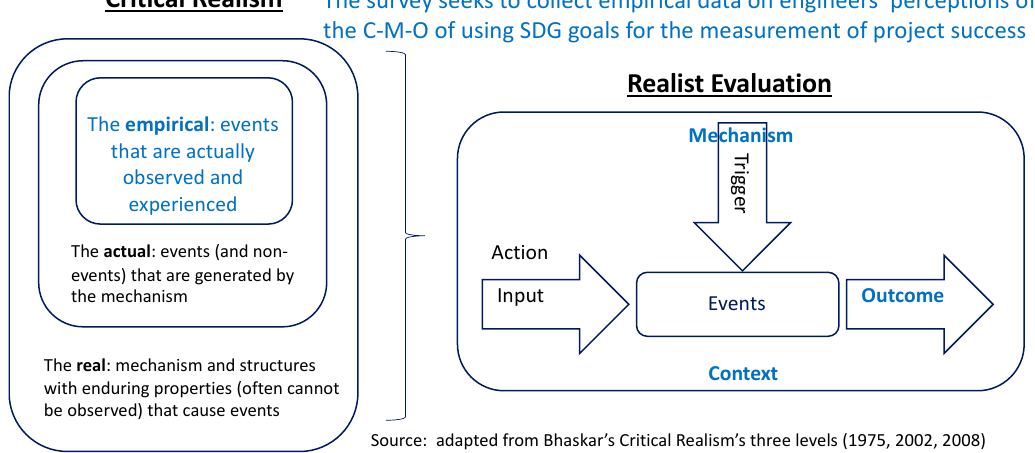
Figure 4. The Realist Evaluation (Context–Mechanism–Outcome (C–M–O)) model mapped to the Critical Realism theory of real-actual-empirical adapted from Zachariadis et al. (2013).